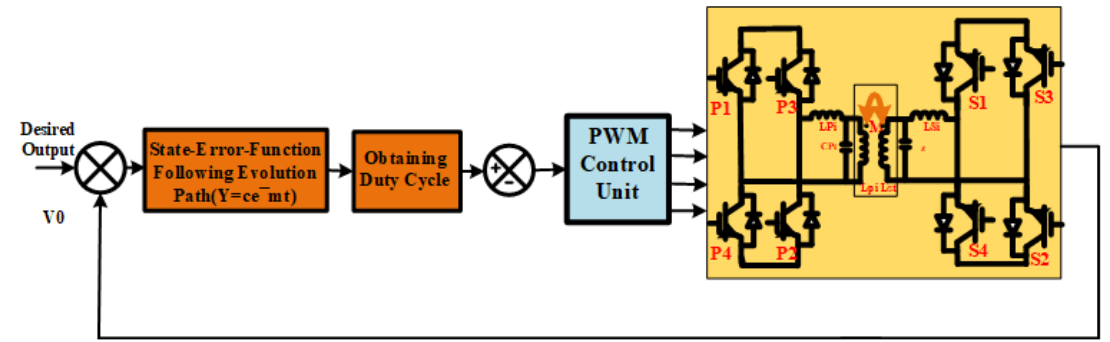
Figure 10. Dynamic Evolution control-interfaced BWPT system.